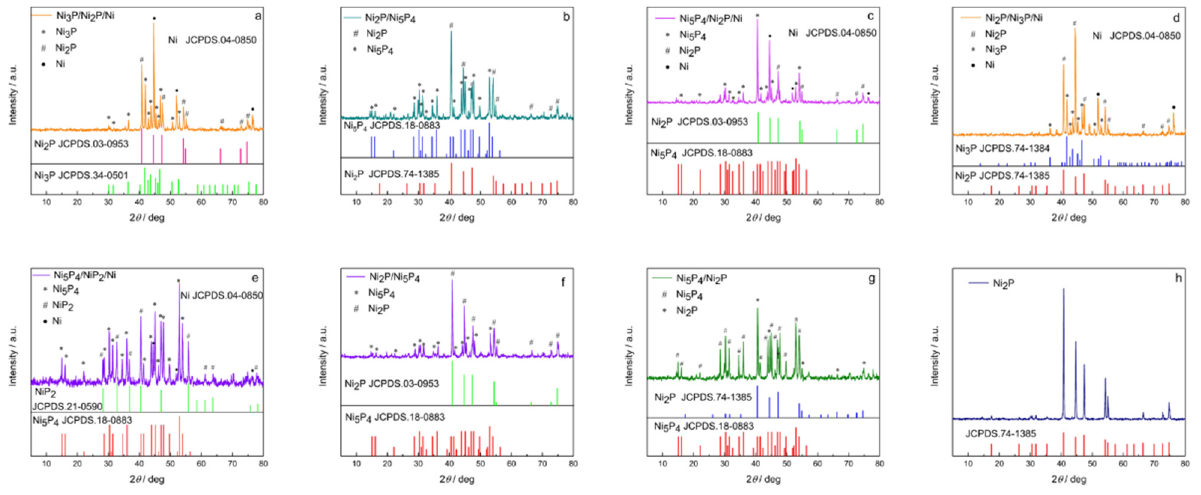
Figure 1. X-ray diffraction patterns of the samples in various Ni/P ratios. ( a – d ) XRD pattern of Ni/P ratio 3:1, 5:2, 12:5, and 7:3. ( e – h ) XRD pattern of Ni/P ratio 2:1, 5:4, 1:1 and single-phase Ni 2 P.